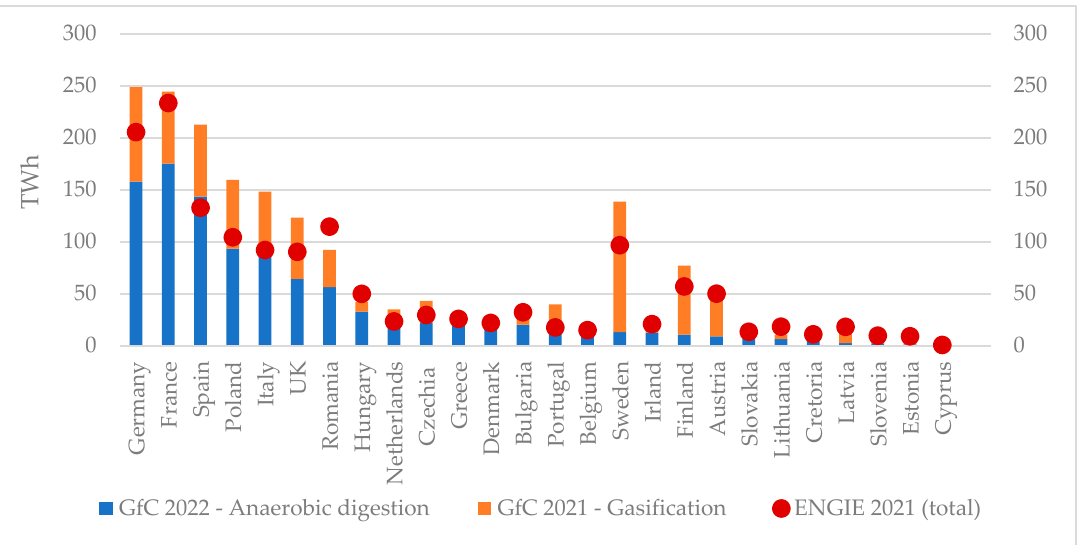
Figure 8. The potential of biomethane production in the perspective of 2050 in EU countries and the UK. Source: own elaboration based on Alberici et al. and Birman et al., 2021 [25,69].